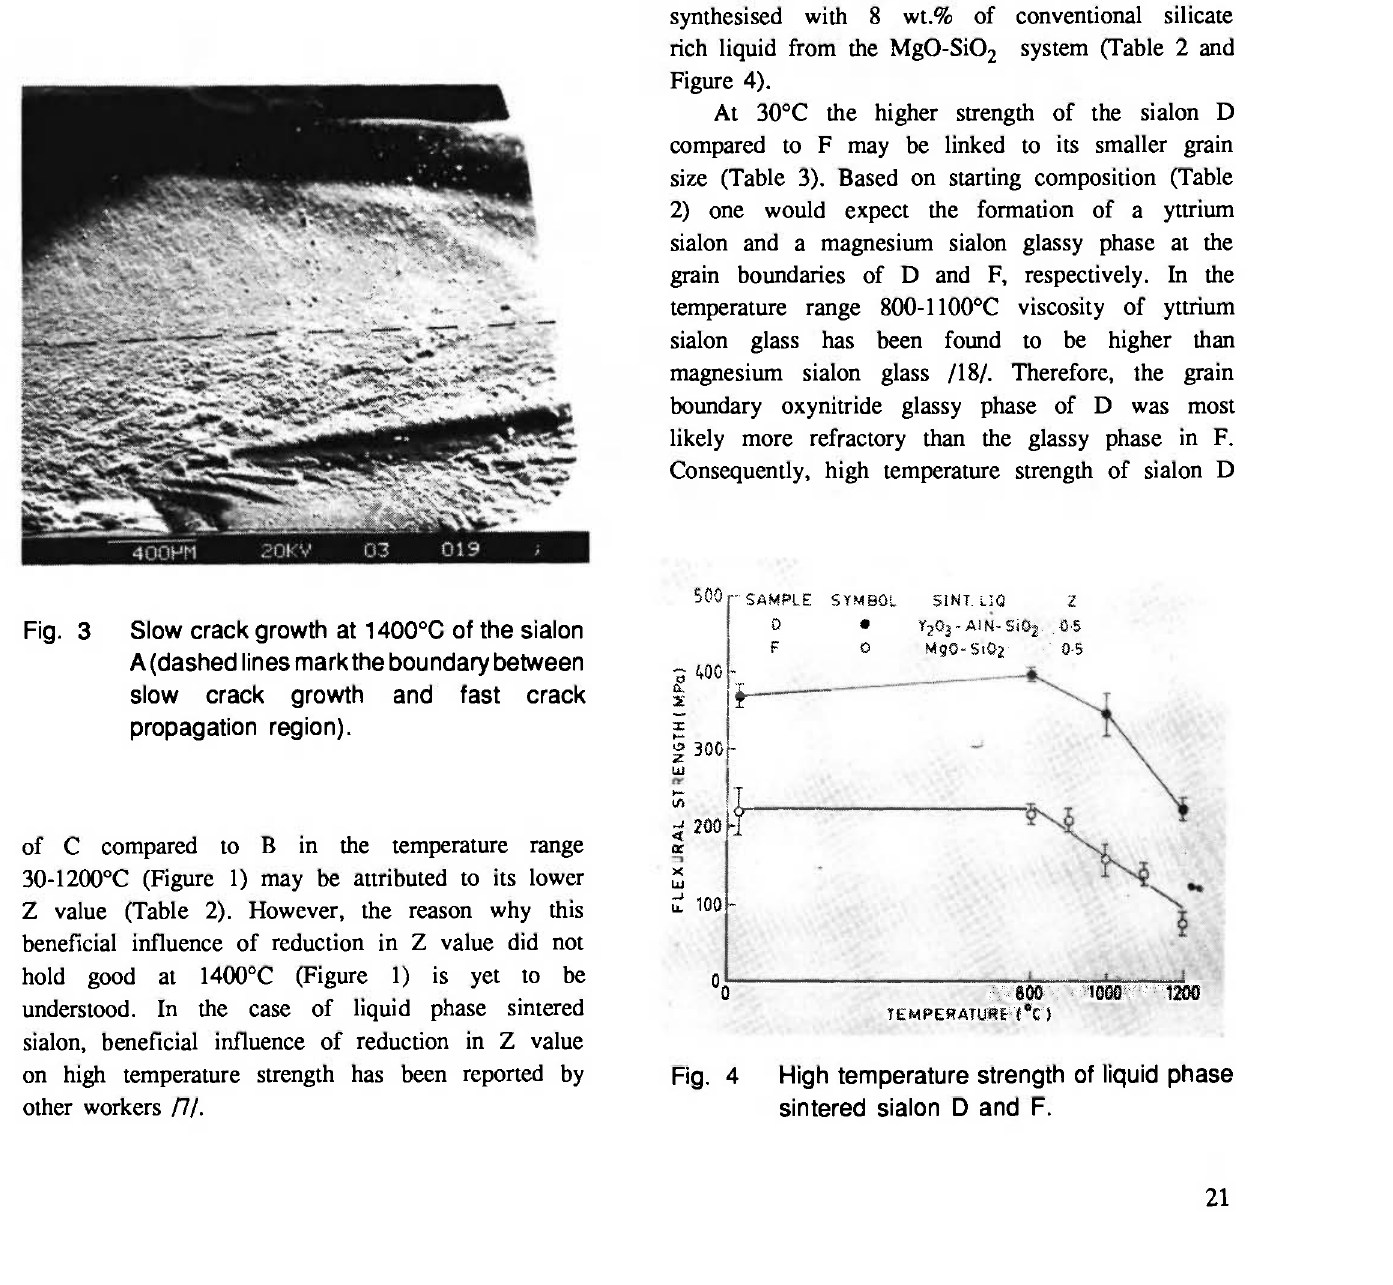
Fig. 2 Typical load-deflection behaviour in the temperature range 30-1400°C of the sialon A.